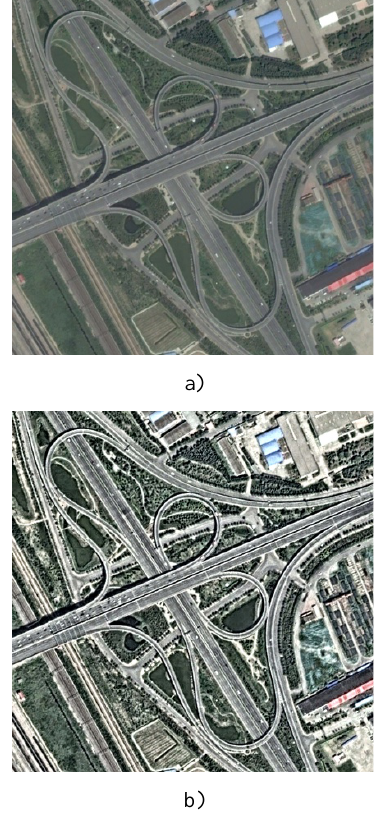
Fig. 6 . Enhancement results for the Image #3.